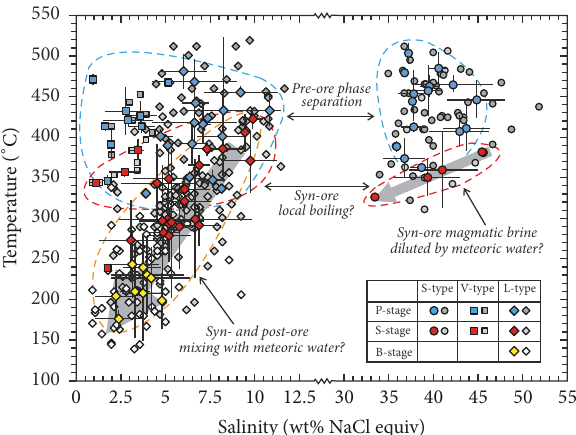
Figure 7: Homogenization temperature versus salinity plot of fluid inclusion assemblages (in color). Error bars are at 1 𝜎 level. Individual fluid inclusion analyses in each assemblage are also plotted in black and white. P-, S-, and B-stage refer to pre-, syn-, and postmineralization stage, respectively.